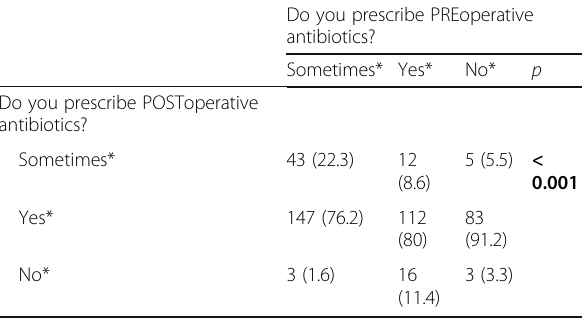
Table 12 Relationship between preoperative and postoperative antibiotic prescribing